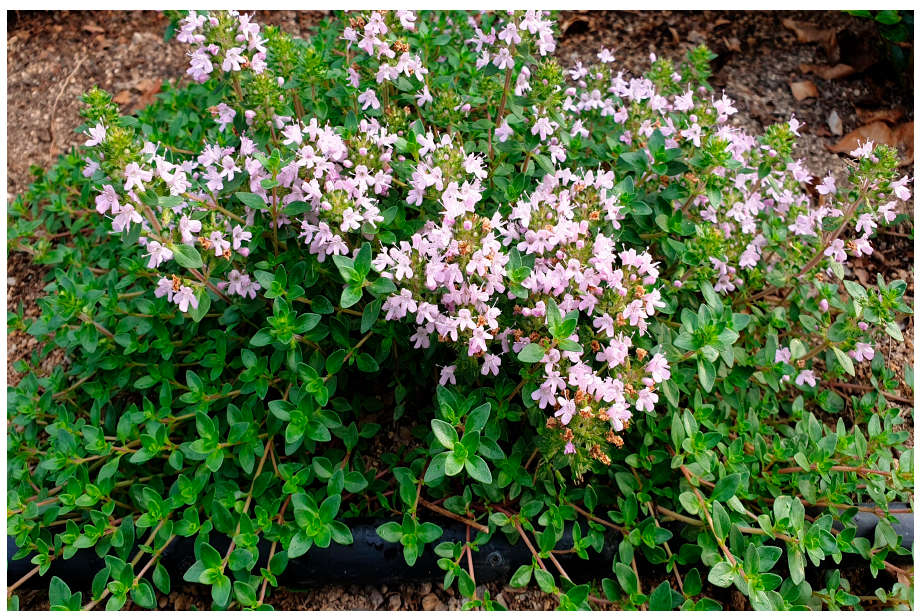
Figure 1. Fully grown T. quinquecostatus plant with flowers.